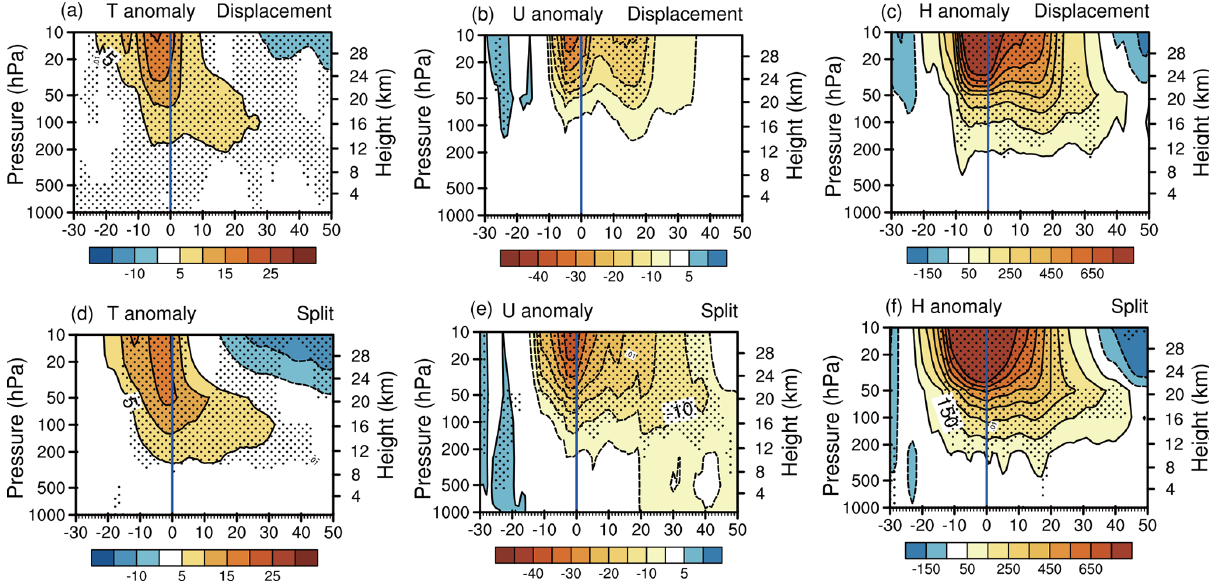
Figure 1. Composite pressure–temporal evolution of the SSW from day − 30 to day 50 relative to the onset date for vortex displacement SSWs (a–c) and vortex split SSWs (d–f) . (a, d) Temperature anomalies over the polar cap from 60 to 90 ◦ N (interval: 5; units: ◦ C). (b, e) Zonal-mean zonal winds at 60 ◦ N (interval: 5; units: ms − 1 ). (c, f) Geopotential height anomalies over the polar cap from 60 to 90 ◦ N (interval: 200; units: gpm). The onset date of the SSW is marked by a vertical blue line. Black dots indicate the composite anomalies at the 95% confidence level using the t